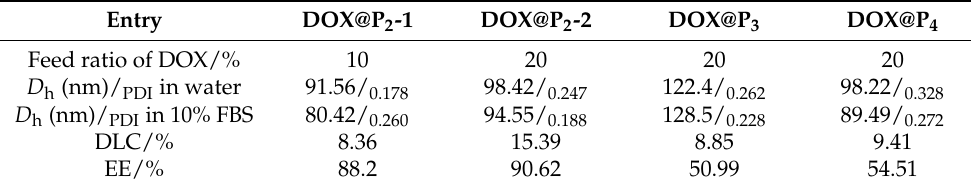
Table 3. Summary of the mean sizes and polydispersity indexes (PDIs) determined by DLS in water and 10% FBS at a polymer concentration of 0.5 mg/mL, as well as the drug-loading content (DLC) and encapsulation efficiency (EE) of these five theranostic unimolecular drug-loaded micelles